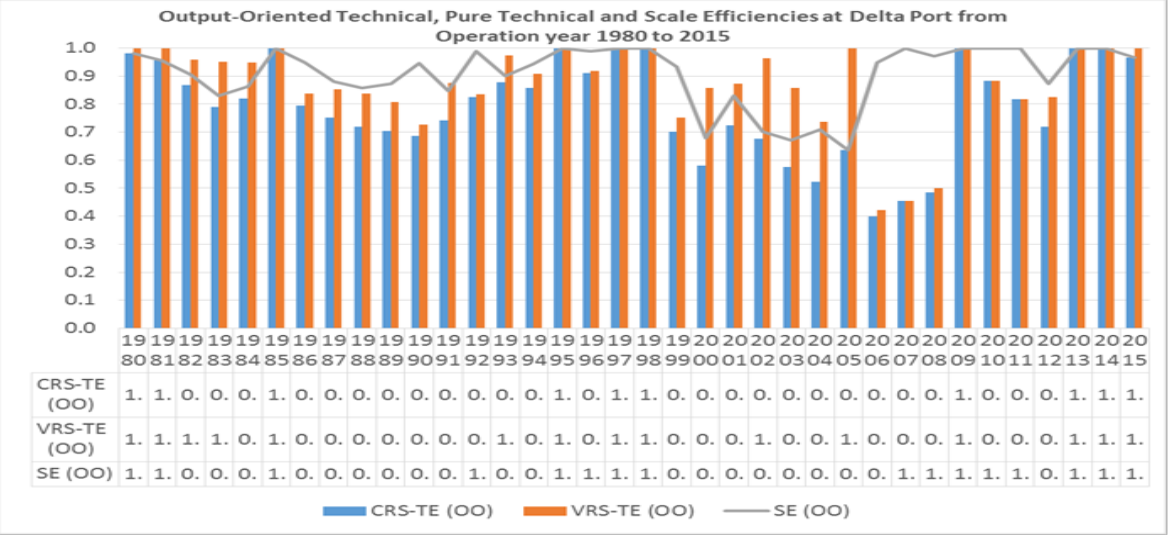
Figure 8: CRS – Technical Efficiency (Output-oriented) and CRS – Scale Efficiency (Output- oriented) at Delta Port Complex from 1980 –